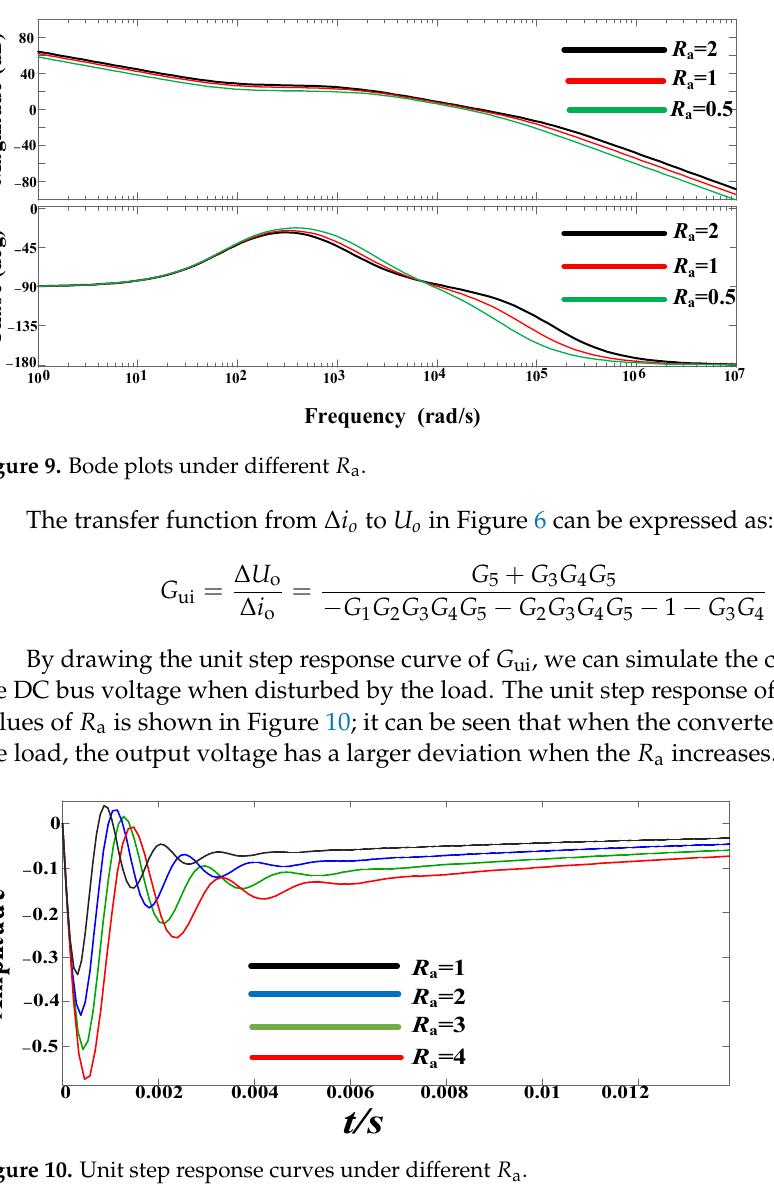
t /s t 4 Figure 11. Output voltage curve of the converter when disturbed . Table 1. Values of J , H, and 𝑅 (cid:2911) . Time